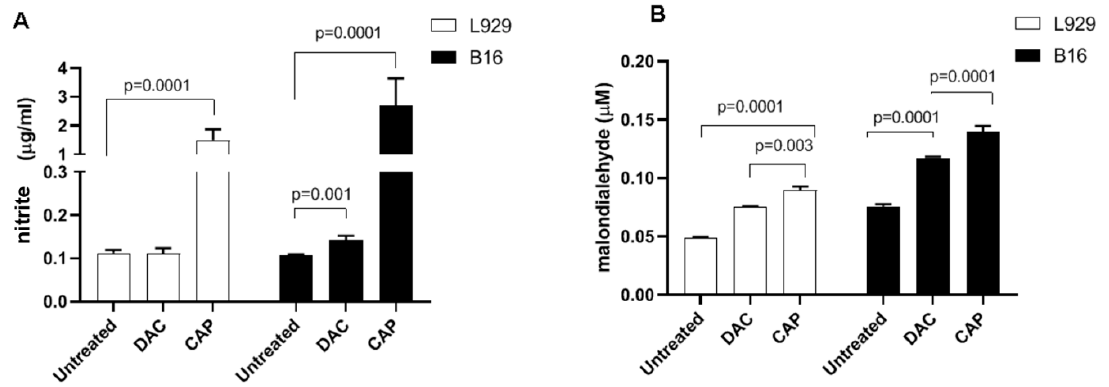
Figure 3. Quantification of nitrite and MDA. The levels of nitrite ( A ) and MDA ( B ) were measured in B16 and L929 cell supernatants and following exposure to the mono and combination treatment. Data are presented as the mean + SD of five technical replicates experiments.